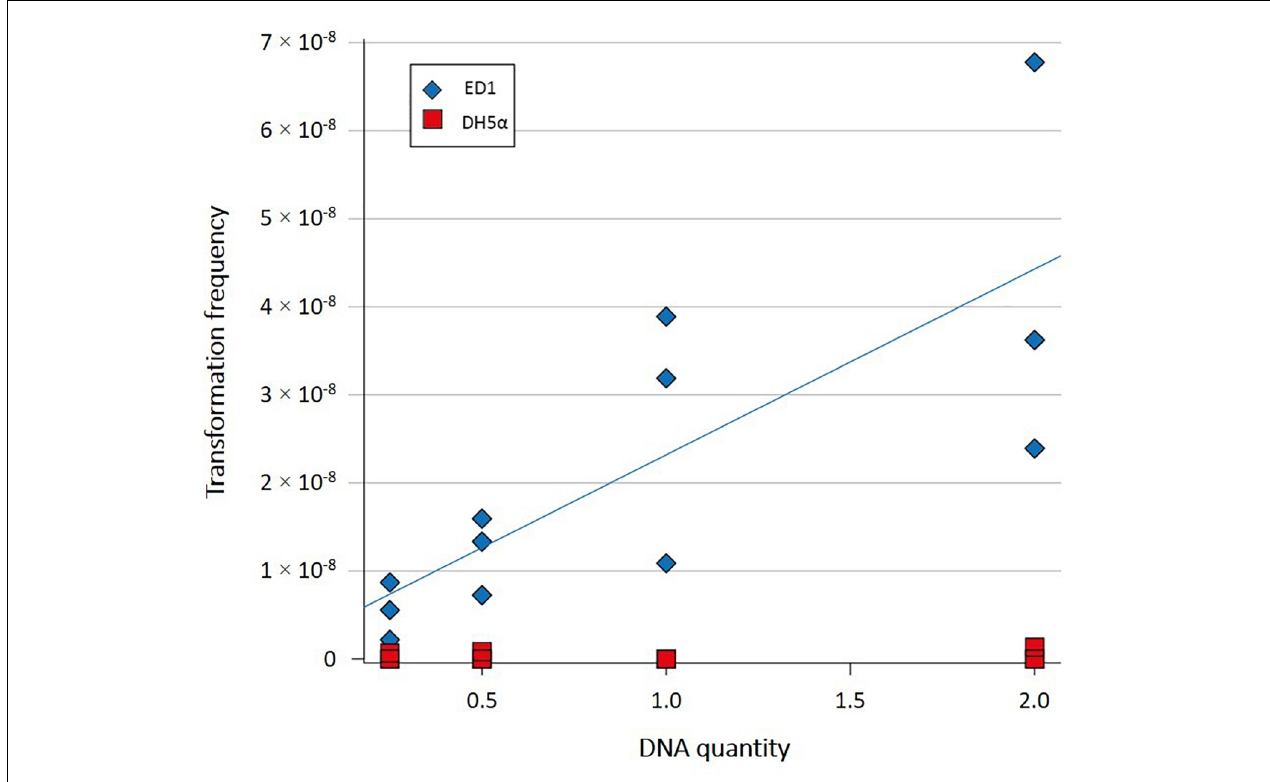
FIGURE 2 | Transformation frequencies of E. coli strains ED1 and DH5 α in Milli-Q water with increasing quantities of plamidic DNA. Transformation frequency of ED1 strain was significantly related to the amount of plasmid added (linear model: t = 3.9, p = 0.003).